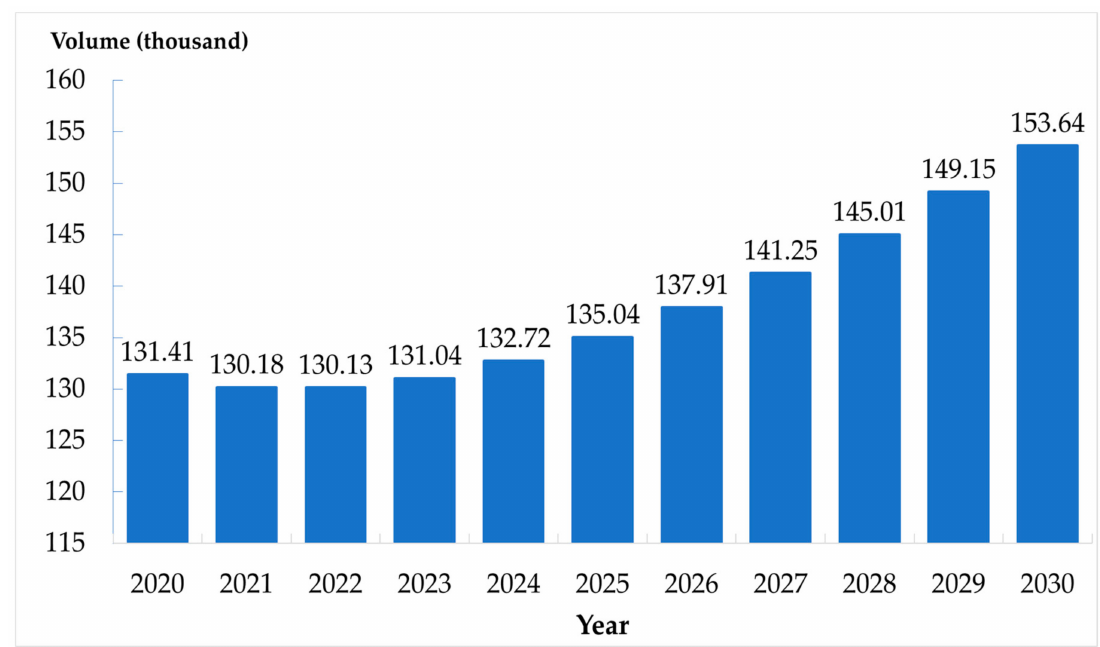
Figure 4. Number of the elderly in bedridden group in Thailand, 2020–2030.